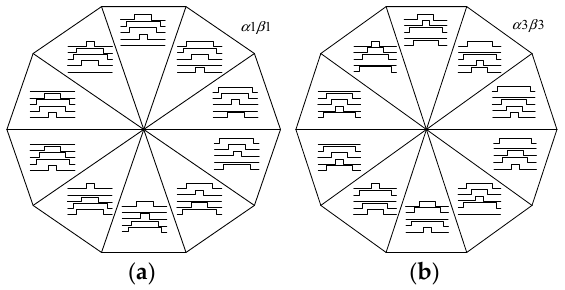
Figure 4. Non − zero vector switching signal distributions of the DFV − SVPWM algorithm on double plane: ( a ) in α 1 - β 1 subspace; ( b ) in α 3 - β 3 subspace.